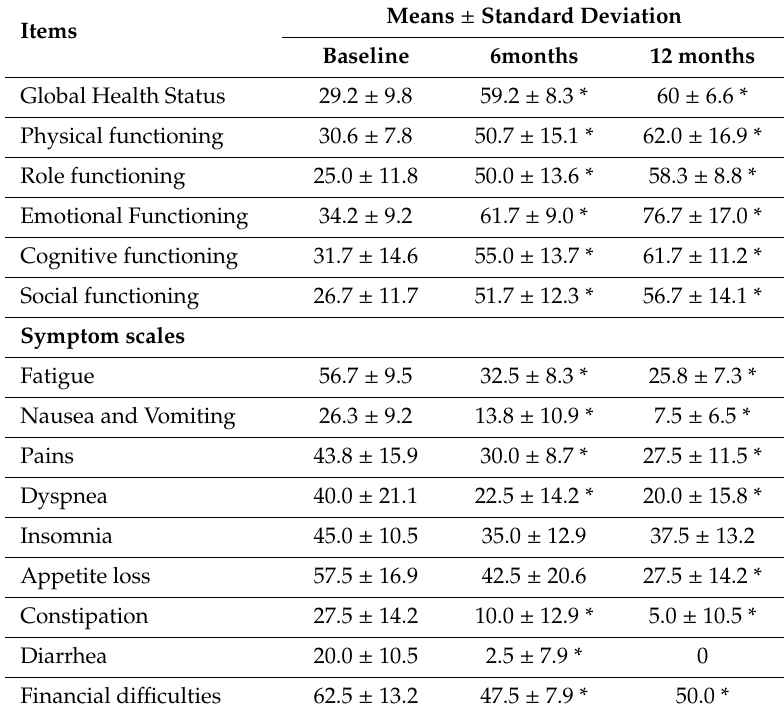
Table 4. Quality of life improvement after immune cells transplantation.